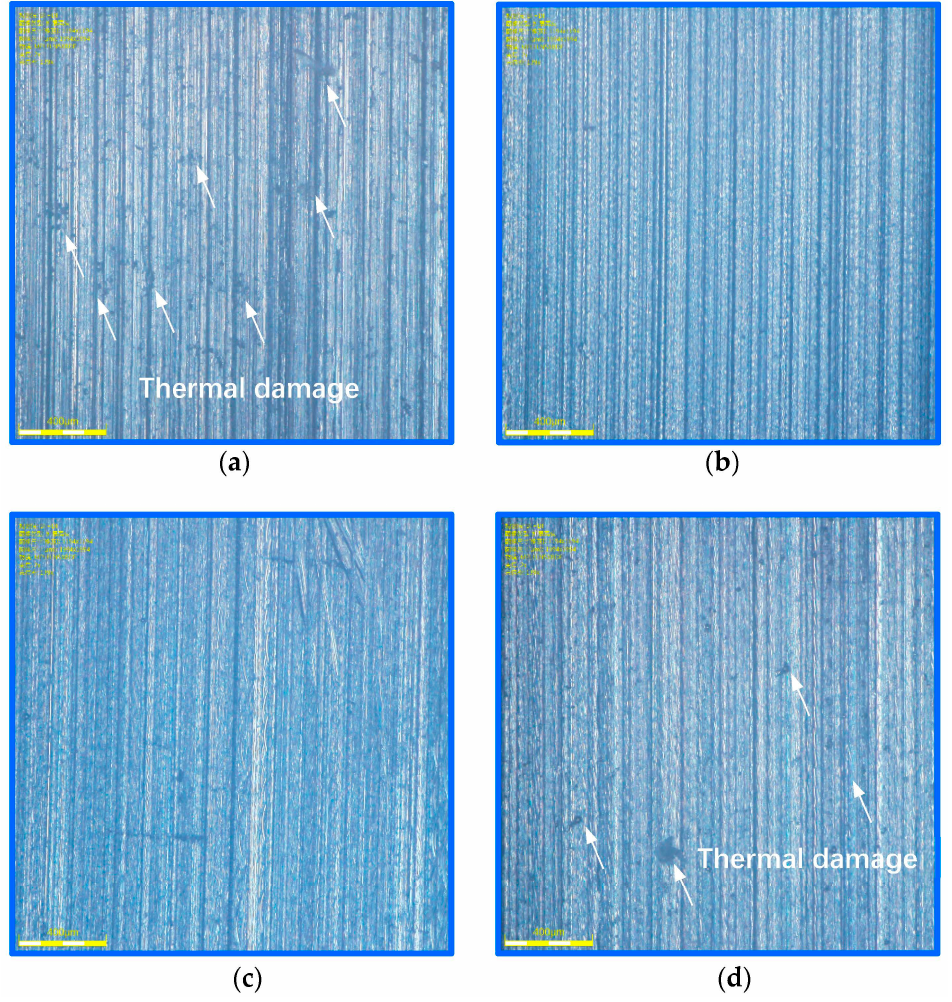
Figure 7. Surface texture comparison of group 1: ( a ) 𝐴 = 0 , ( b ) 𝐴 = 8 μm , ( c ) 𝐴 = 10 μm , and ( d ) 𝐴 = 12 μm . ( d ) A = 12 µ